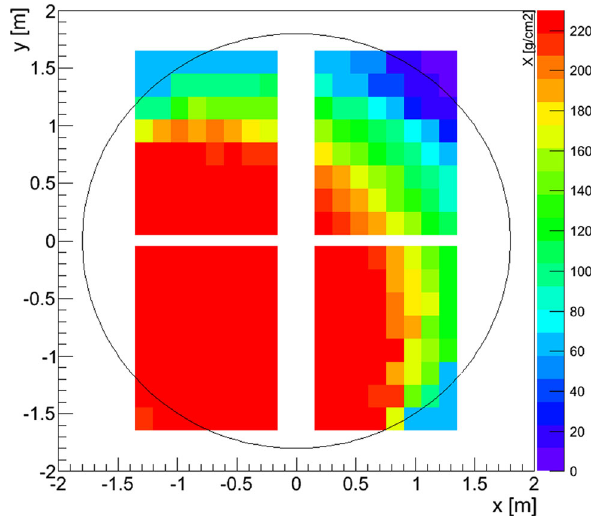
Fig. 4 Slant mass crossed before reaching the MARTA RPCs, under a 170 g/cm 2 vertical mass overburden, for incident particles at 40 ◦ zenith angle. The circle indicates the area covered by the water